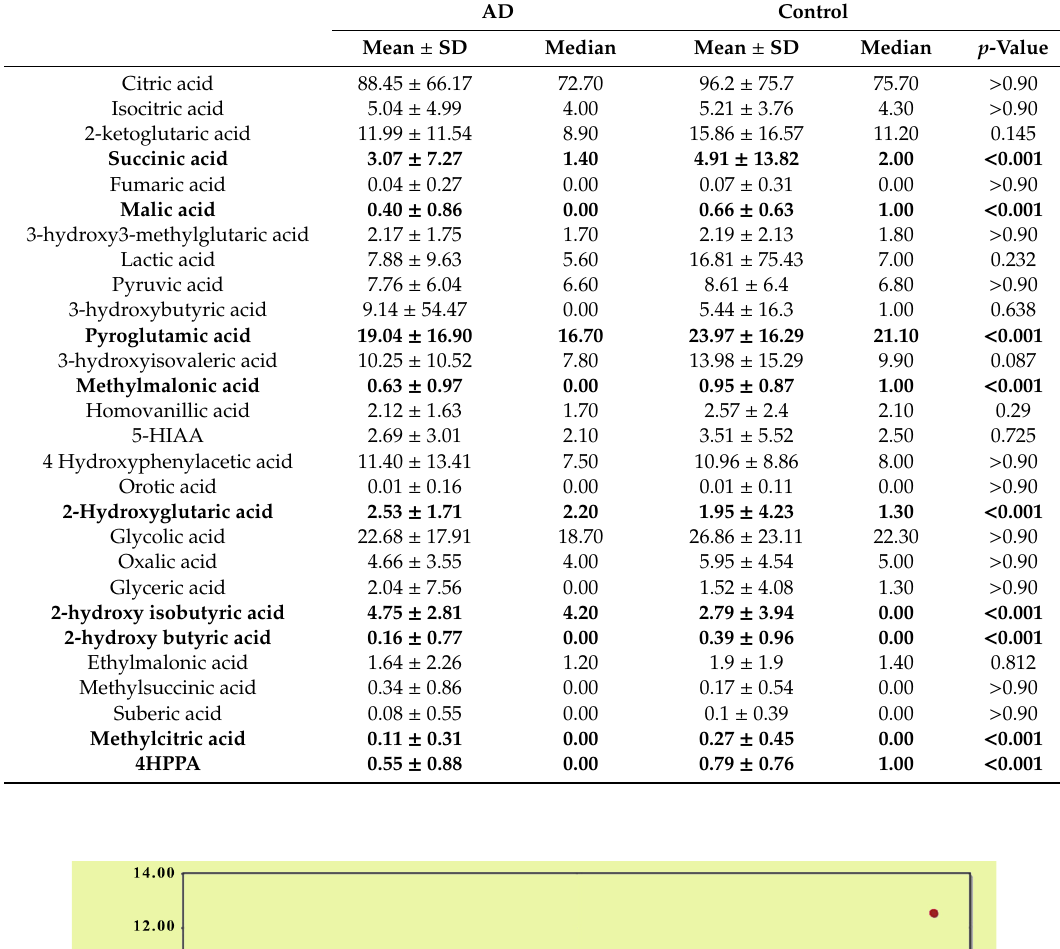
Table 1. Comparative organic acids analysis in the autoimmune diseases (ADs) group compared to control. Concentrations of organic acids are expressed as mmol / mol Creatinine. Non-Parametric Mann-Whitney test with Bonferroni Correction, Ho: The distribution of characteristics is the same between the groups. Bold indicates that the variables are considered statistically significant ( p < 0.05) based on Bonferroni correction.